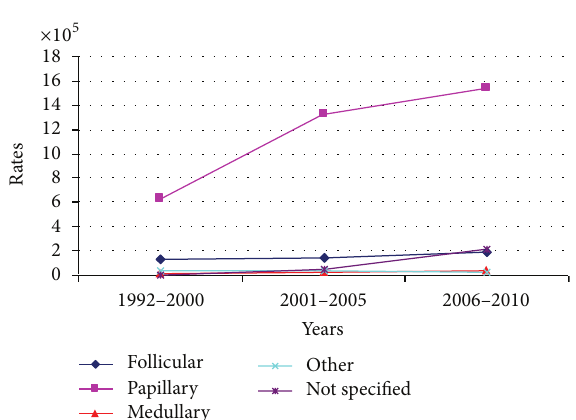
Figure 3: Trend of histological subtypes rates.